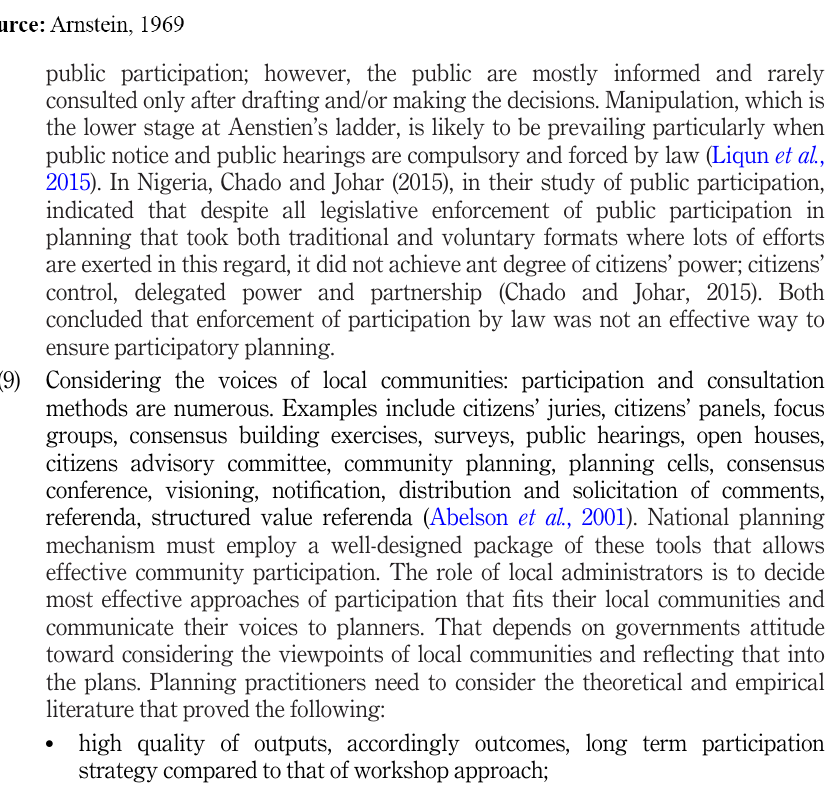
Figure 2. Sherry Arnstein ’